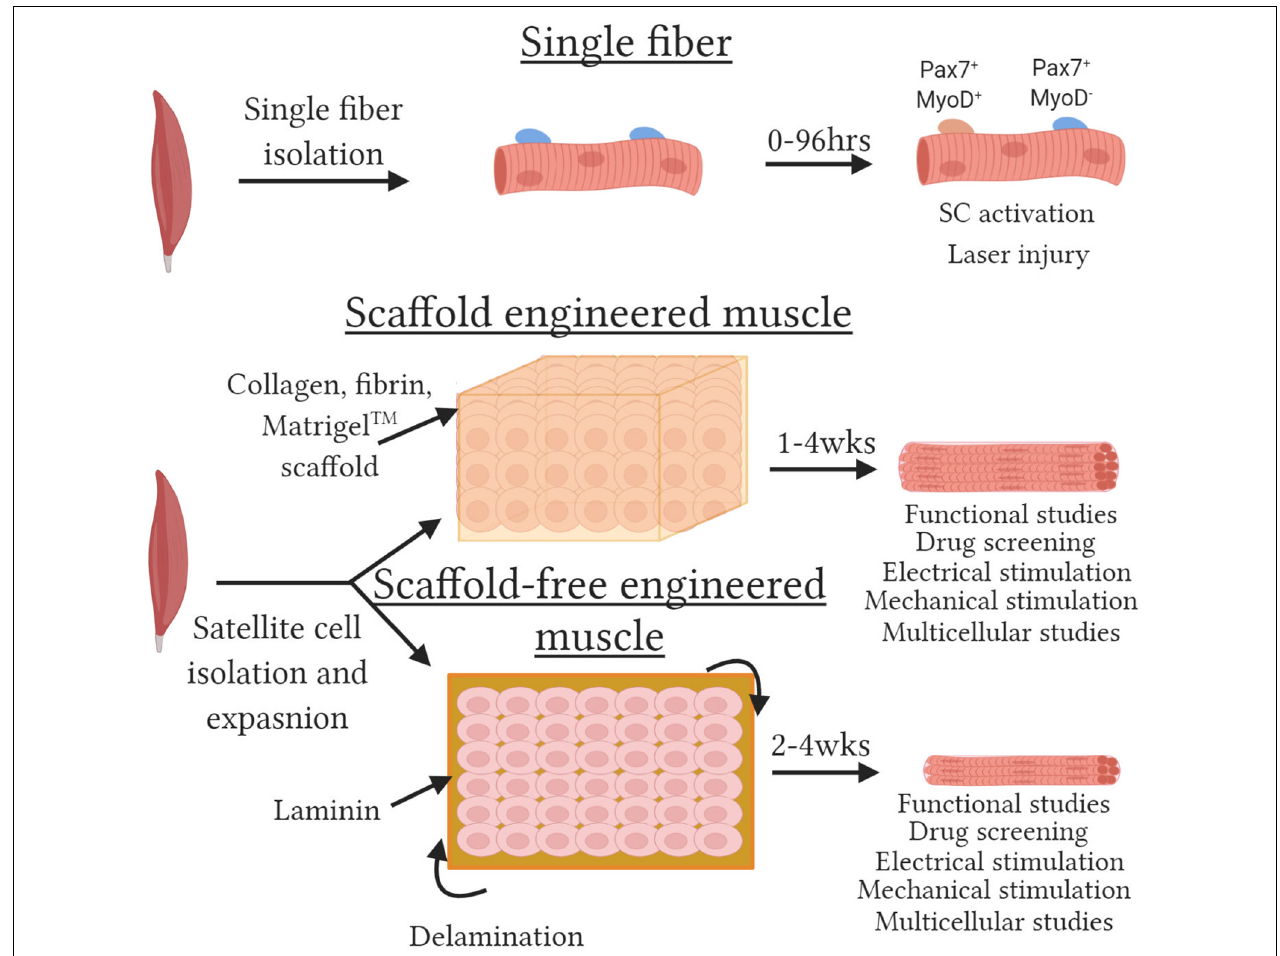
FIGURE 1 | Methods to engineered functional skeletal muscle. Schematic depicting various skeletal muscle models. (Top) Single fibers with satellite cells retained within their niche are isolated by enzymatic and mechanical dissociation. Single fibers can be cultured for up to 120 h and satellite cell activation assessed by evaluating Pax7 and MyoD expression or resistance to injury susceptibility assessed with laser-induced membrane damage. (Middle) Scaffold engineered muscles are created by embedding muscle progenitor cells at high density in a hydrogel. Cells remodel the hydrogel to generate 3D tissues packed with aligned functional myotubes. (Bottom) Scaffold-free engineered muscles created by seeding a monolayer of cells on laminin coated plates. The cells secrete sufficient ECM and progressive lift off the plate or “delaminate” and roll up to generate small 3D tissues. Both scaffold and scaffold-free tissues can be utilized for multiple assays with multiple functional output for up to 4